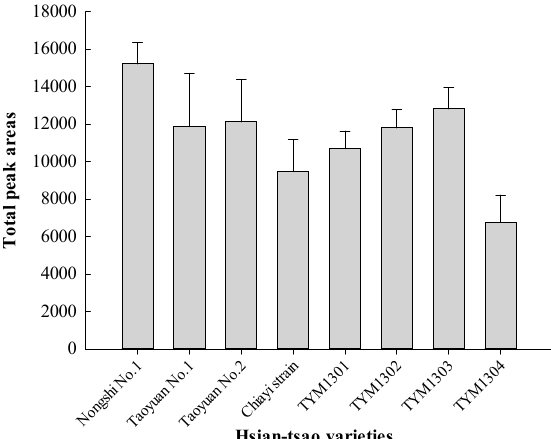
Figure 3. Comparisons of the total peak areas of total volatile compounds of eight varieties of Hsian-tsao (1 g) extracted at 25 °C for 40 min using a DVB/CAR/PDMS fiber. The peak area of a volatile compound or total volatile compounds from the integrator was used to calculate the relative contents using gas chromatography-flame ionization detector (GC-FID). The data corresponds to the mean ± standard deviation (SD) of triplicates.